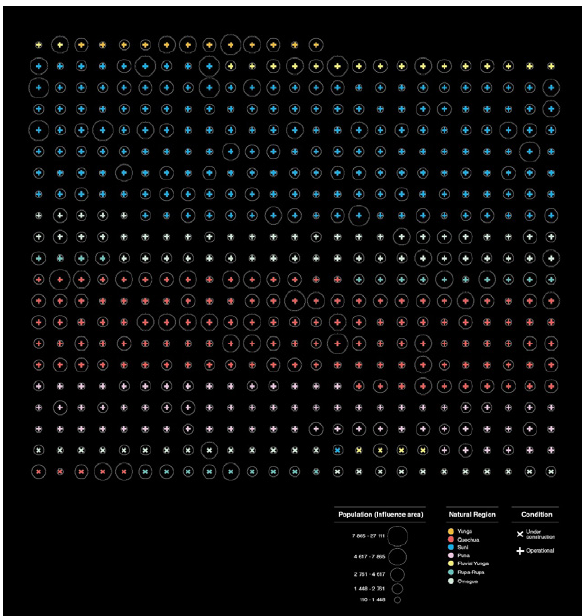
Figure 11. Analysis of the current 514 tambos (source: author, elaboration with data from Tambook , 2017